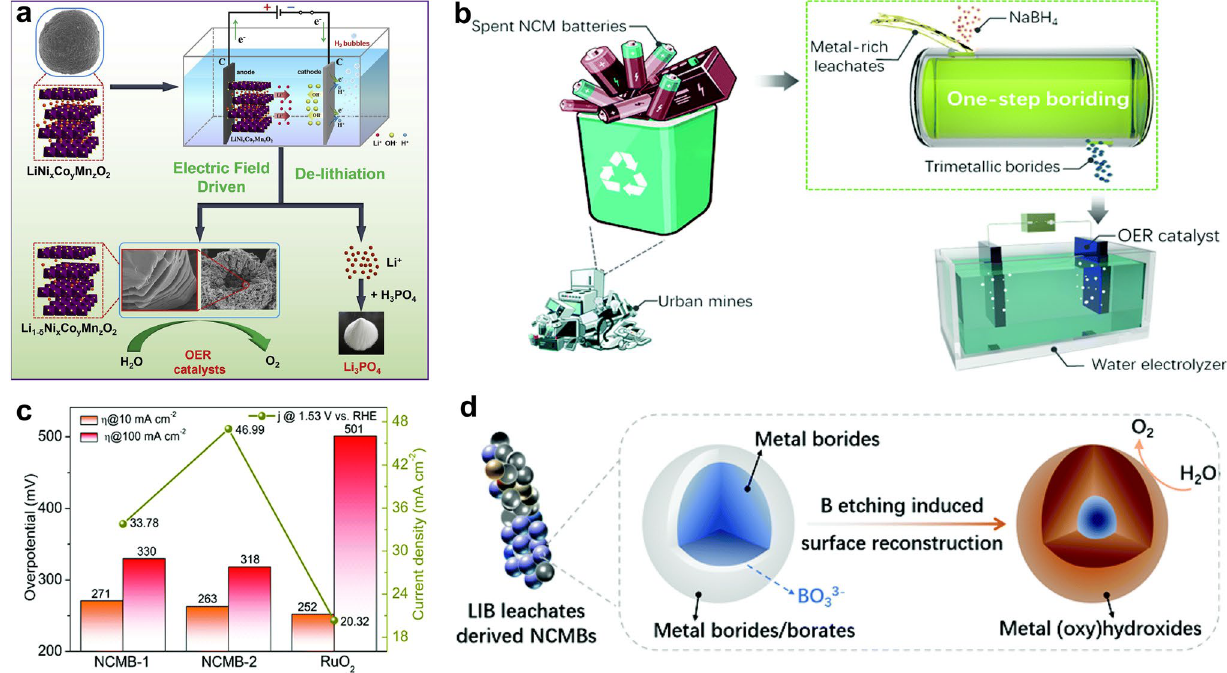
Fig. 9 a Scheme of the electric field‑driven de‑lithiation process for preparing LiNi x Co y Mn z O 2 OER catalysts [149]. Copyright 2021, Elsevier. b Illustration of the fabrication of magnetic NiCoMnB catalysts (NCMBs) from the spent batteries. c η 10 , η 100 , and the current density at 1.53 V (vs. reversible hydrogen electrode, RHE) of catalysts. d Scheme of the surface reconstruction process of spent Li‑ion batteries‑derived